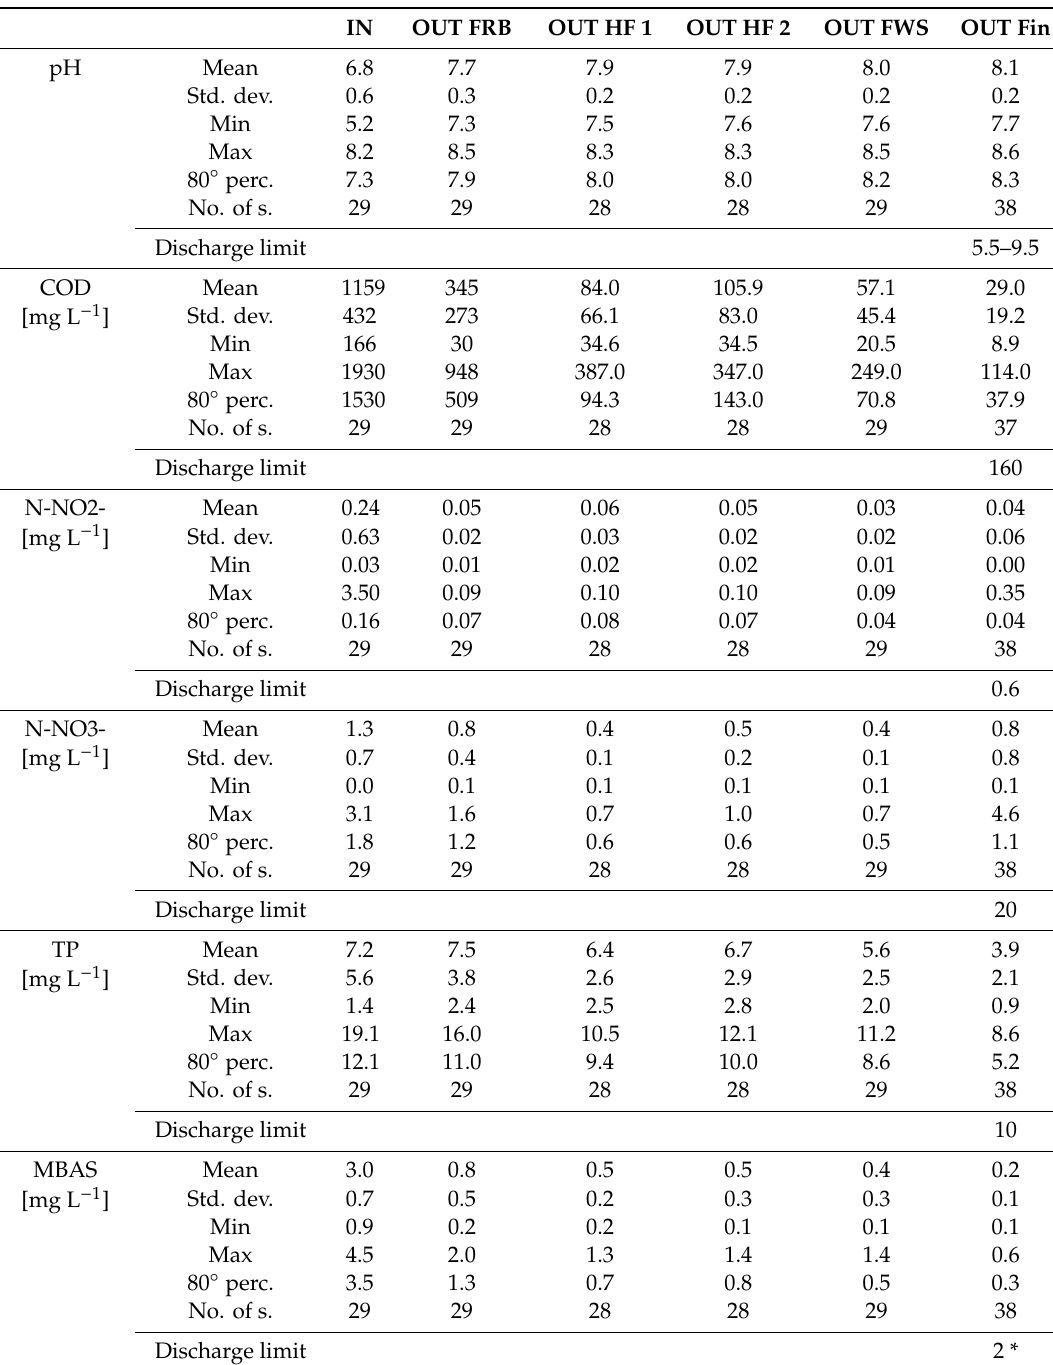
Table 2. Statistical analysis of pollutant concentrations of wastewater treated by the CW of Cecchi winery at the di ff erent stages of the CW of Cecchi winery: influent (IN); e ffl uent from the 1st stage FRB beds (OUT FRB); e ffl uent from the 2nd stage refurbished HF bed (out HF 1); e ffl uent from the 2nd stage HF beds built during the 2009 upgrade (OUT HF 2); e ffl uent from the 3rd stage FWS